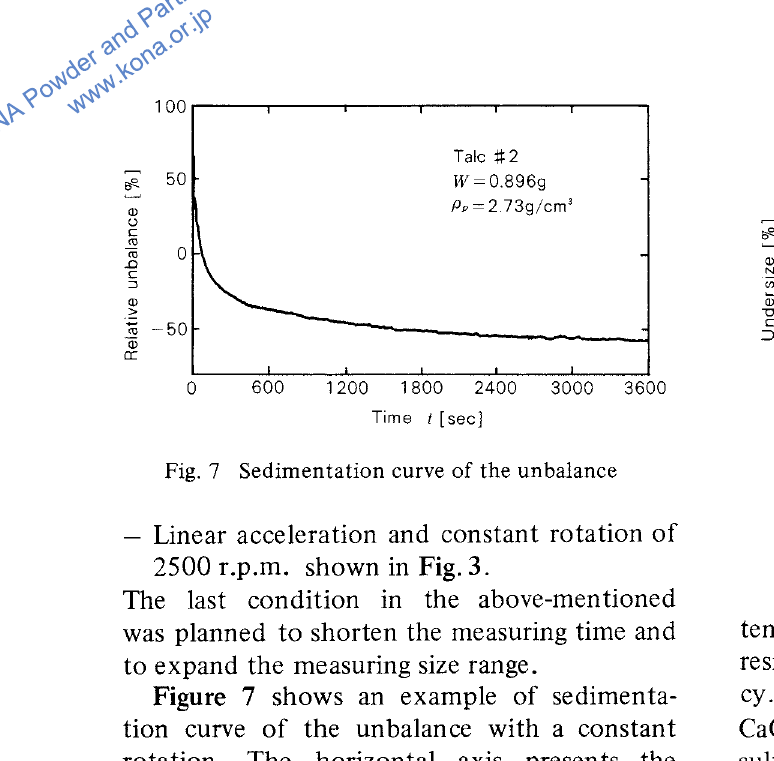
Fig. 9 Comparison of measuring methods